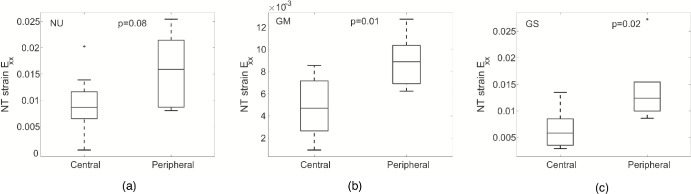
Comparison of EXX at 45 mm Hg in the central and peripheral LC for the (A) NU, (B) GM, and (C) GS groups.